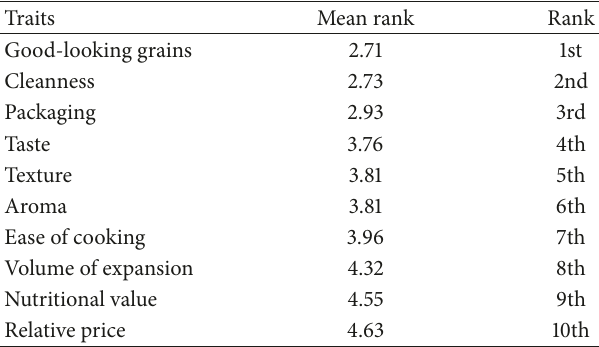
Table 5: Result of the ranked attributes households consider in purchasing